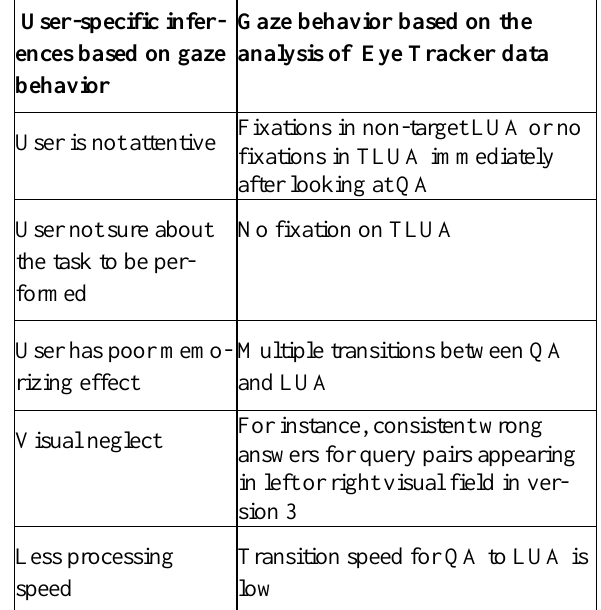
Table 3 Possible findings from eye tracker